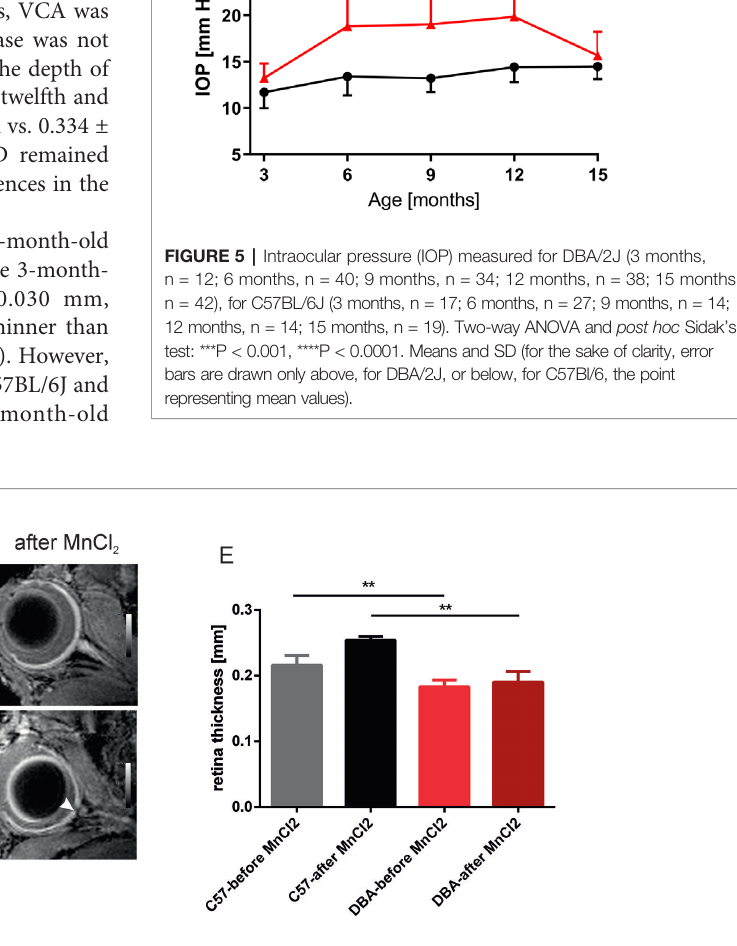
FIGURE 4 | Visualization and quanti fi cation of the retina after systemic administration of manganese. Left panel shows representative T1-weighted images of the eyes before (A , C) and 24 h after (B , D) intraperitoneal injection of manganese chloride in C57BL/6J (A , B) and DBA/2J mice (C , D) . The arrowhead indicates optic disc cupping in DBA/2J mice. (E) Results of quanti fi cation of retina thickness in these mice before and after MnCl 2 administration. **P < 0.01; Kruskal-Wallis non- parametric ANOVA followed by Dunn ’ s multiple comparisons test.